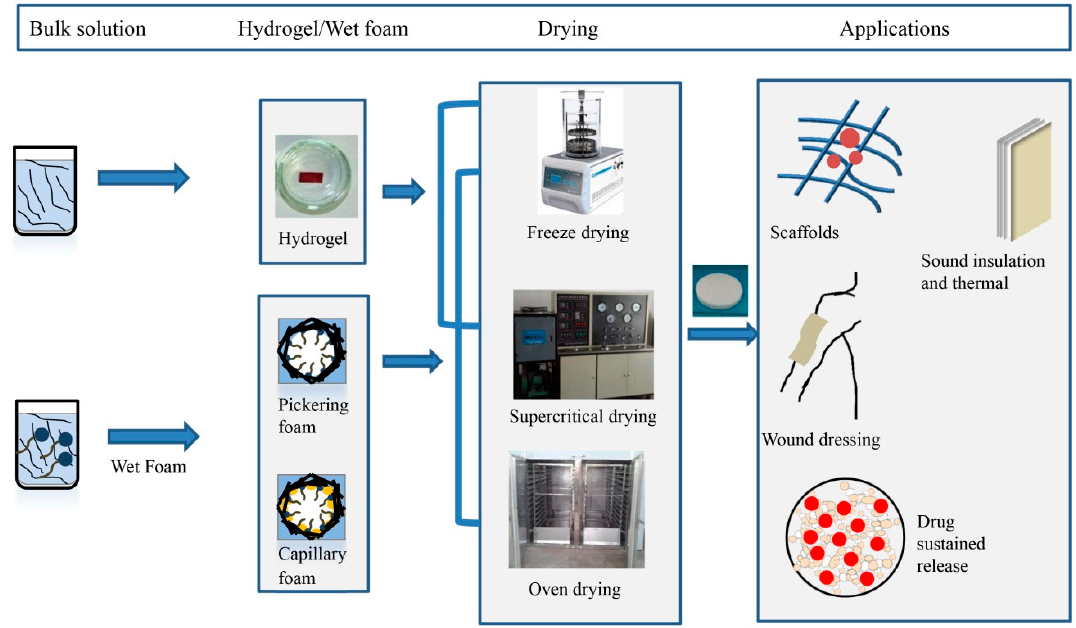
Figure 1. The stability approach and main application of cellulose-based porous materials.